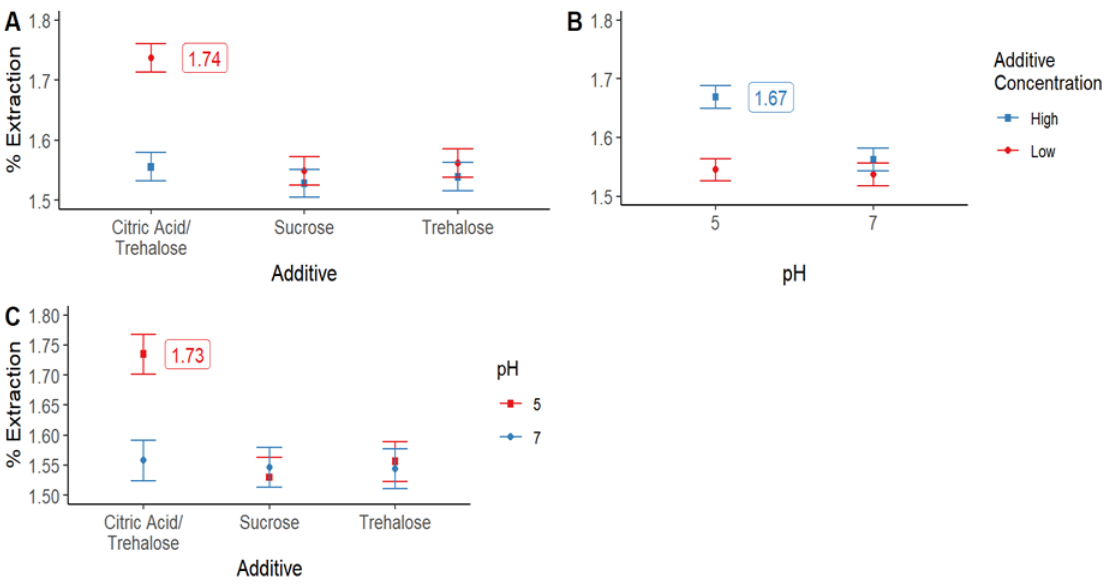
Figure 2. Interaction plots for ( A ) additive vs. additive concentration (trehalose and citric acid, Low = 0.1% High = 0.5%; sucrose, Low = 5% High = 25%); ( B ) pH vs. additive concentration; and ( C ) additive vs. pH. Bars show means and least significant difference intervals for 95% confidence.